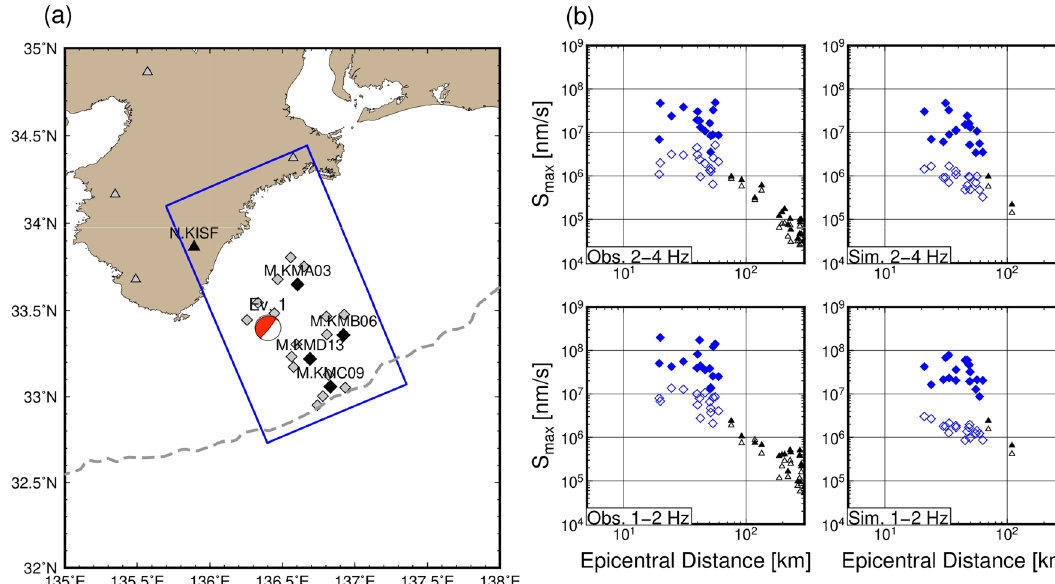
Fig. 12 a Map of simulation settings and b comparisons between simulated and observed amplitudes for frequency ranges of 1.0–2.0 Hz and 2.0–4.0 Hz. The blue solid rectangle and red focal mechanism in a are the model region and assumed source model, respectively. b Plots of the S max amplitudes at the DONET and F-net stations. The filled blue and open diamonds are horizontal and vertical amplitudes at DONET stations, respectively. The filled and open triangles are those at F-net